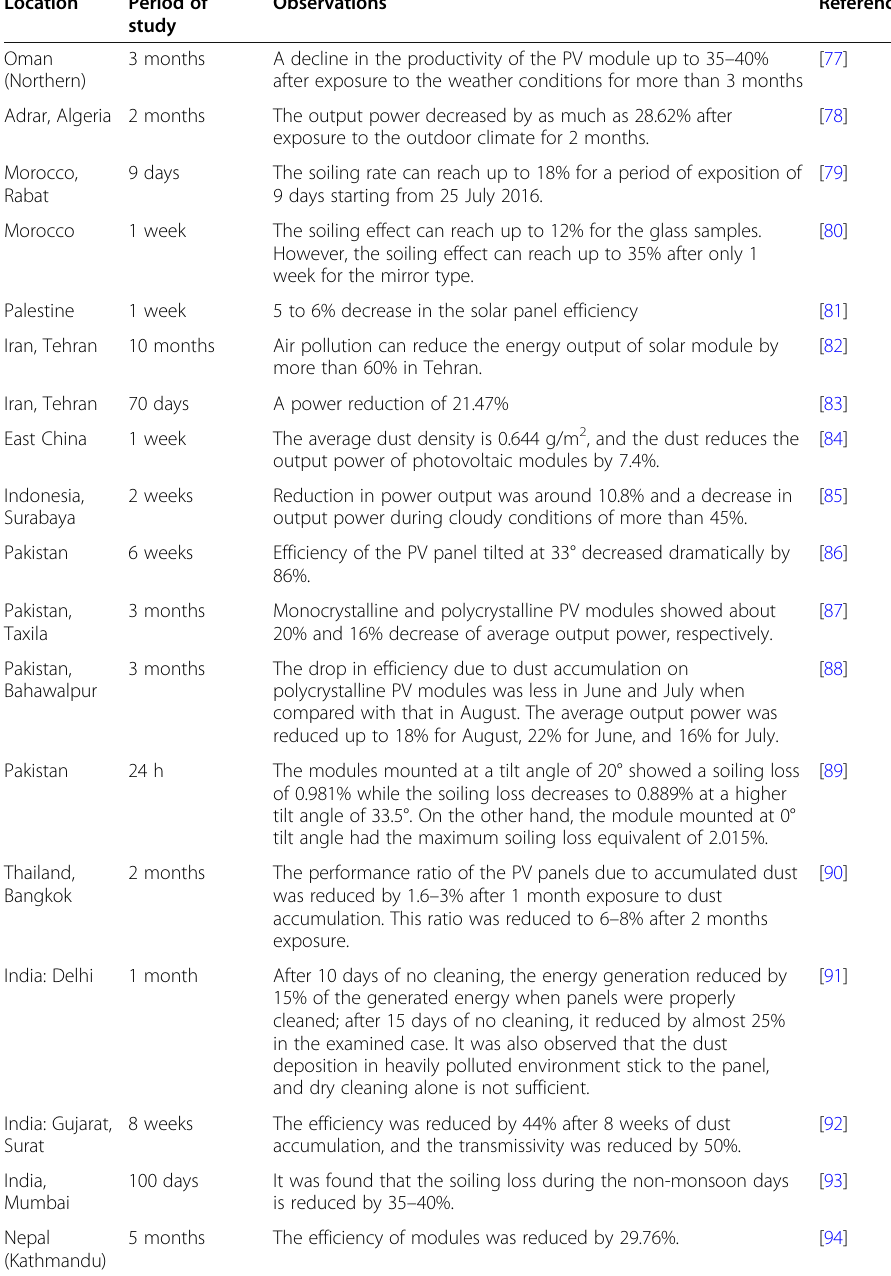
Table 2 Summary of selected reports of dust effects on the performance of PV panels in some countries of the MENA and the Far East regions